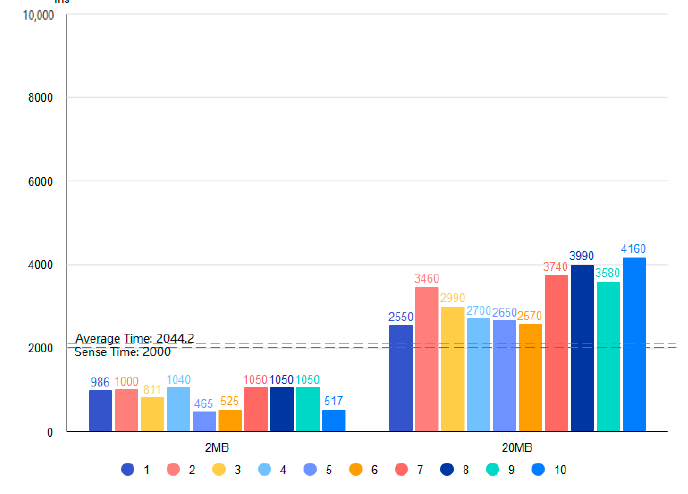
Figure 12. Time test of Pattern III.